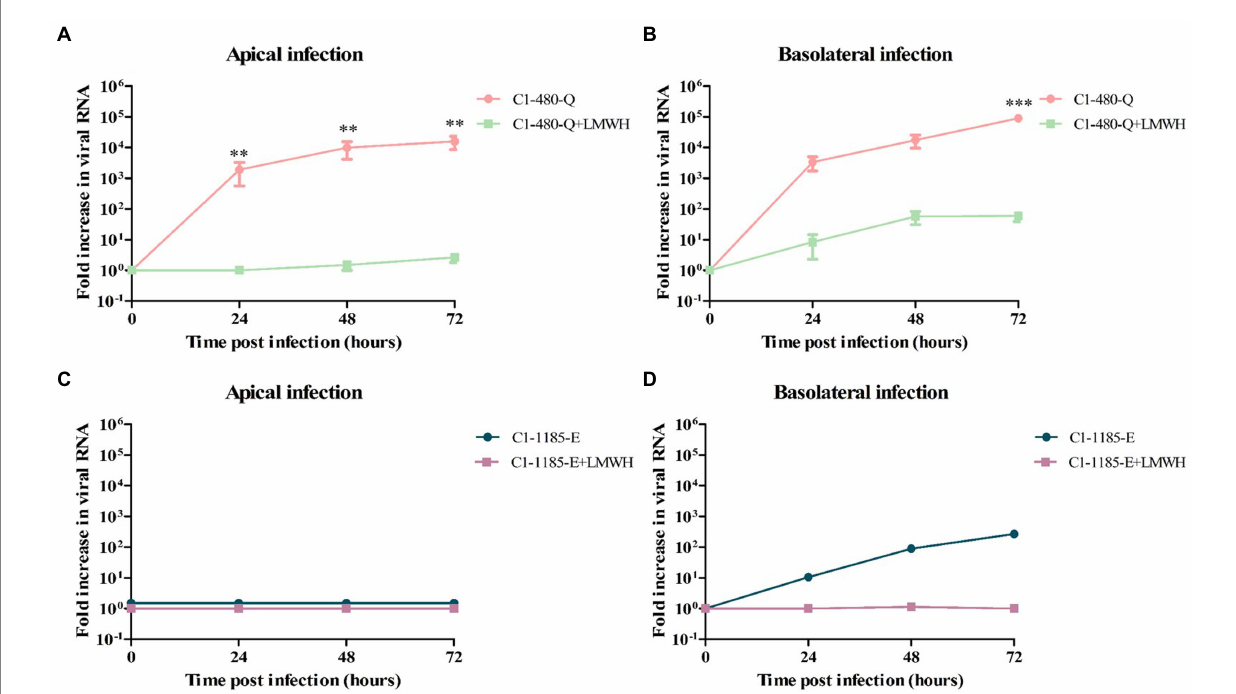
FIGURE 4 The susceptibility of C1-480-Q and C1-1185-E to HSPG-binding in fetal intestinal organoid-derived monolayers. (A–D) Fold increase in viral RNA in media collected at different time points from the apical compartment after apical (A,C) and basolateral (B,D) inoculation with and without pre- treatment with LMWH. In all cases, data represent the geometric mean ± SEM of four biological replicates with two technical replications per biological replicate. ** value of p <0.01; *** value of p